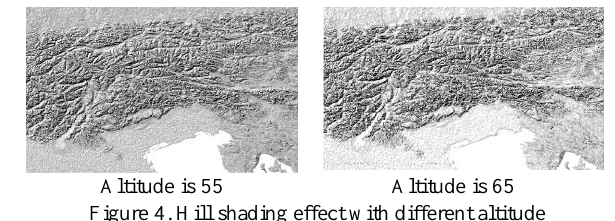
Figure 4. Hill shading effect with different altitude Also, the optimization for azimuth should consider and adjust